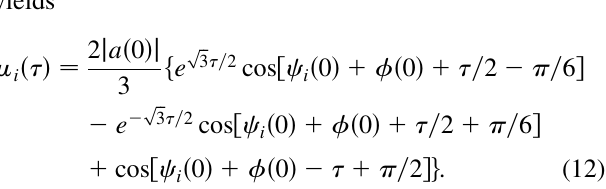
FIG. 1. (Color) Electron distributions in a phase plane of (cid:1) (cid:2) (cid:6) (cid:4) derived from Eqs. (12) and (13) when (cid:6) = 9 (crosses), and (cid:10) i 10 (open squares), 11 (open circles). The time evolution of four different electrons, initial phases of which are (cid:2) 0 (cid:4) (cid:3) (cid:1)= 2 (dotted line), i (cid:2) 0 (cid:4) (cid:3) 3 (cid:1)= 2 (dashed line), are also shown. The initial i